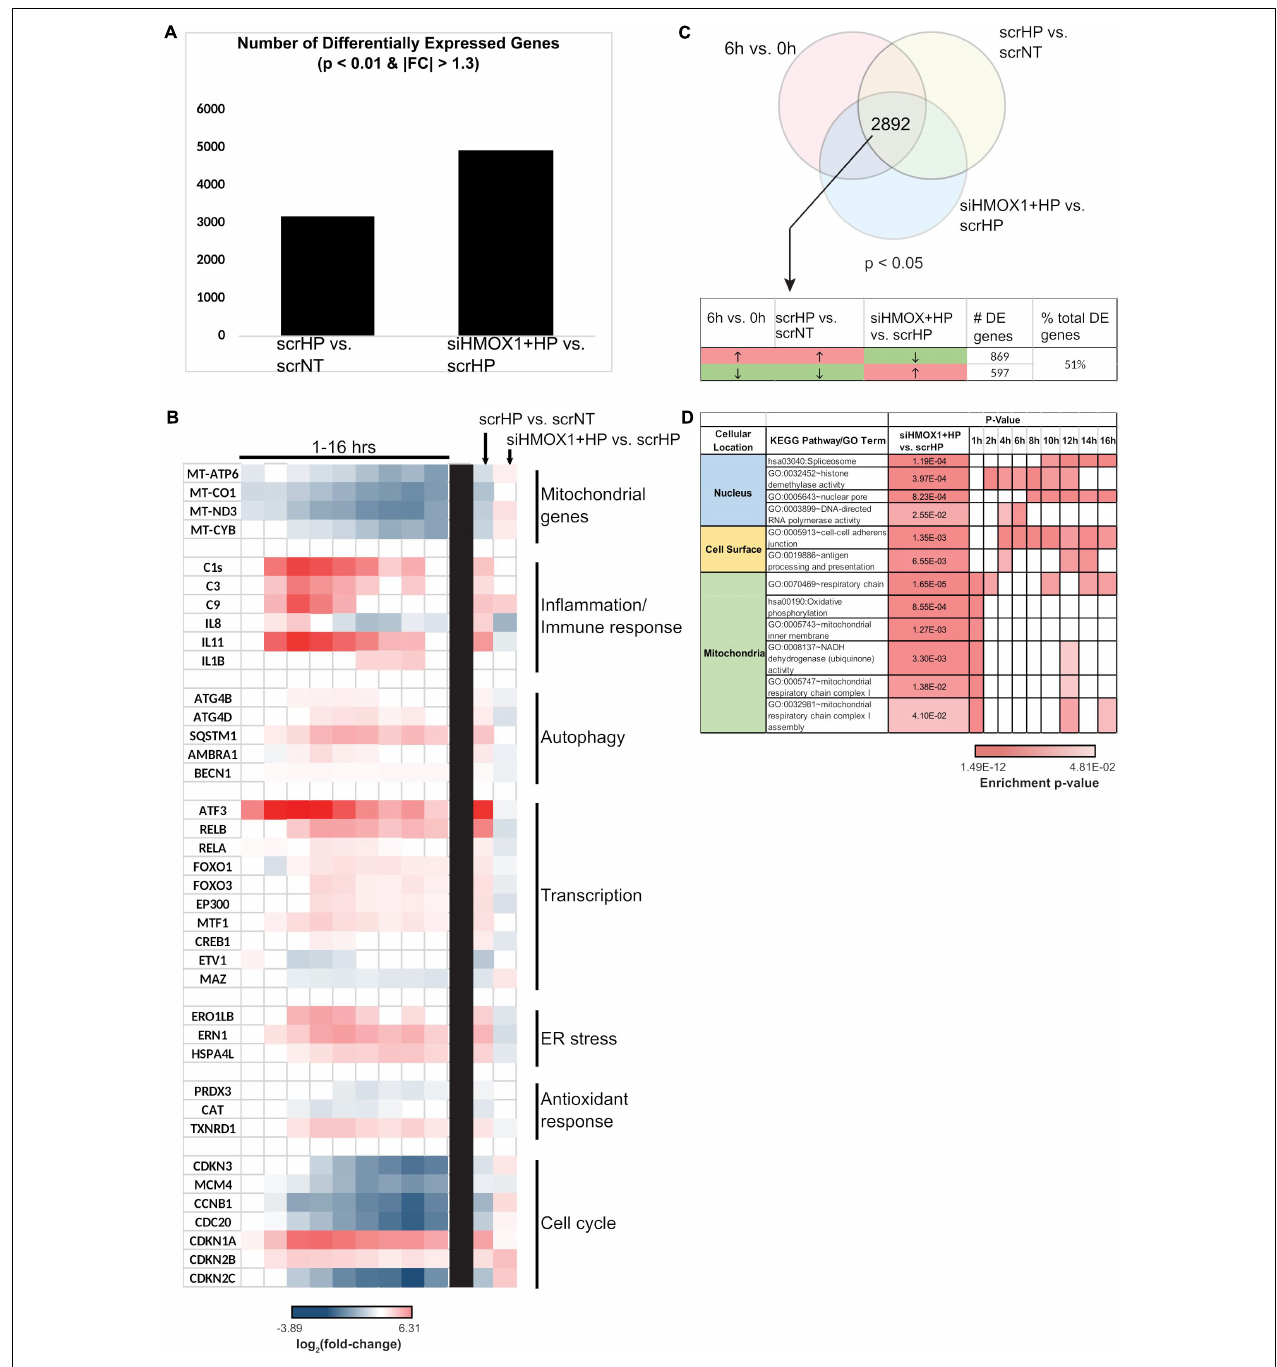
FIGURE 4 | HMOX1 is a global regulator of cell function in HUVECs upon HP treatment. RNA collected from scrNT, scrHP, and siHMOX1+HP samples ( n = 2 per group) was submitted for RNA-seq. (A) The number of differentially expressed genes between scrHP vs. scrNT (i.e., indicating the effect of the HP treatment) and between siHMOX1+HP vs. scrHP (i.e., indicating the effect of the HMOX1 knockdown in response to HP treatment). (B) Log 2 (fold-change) of genes associated with mitochondrial function, inflammatory/immune response, autophagy, transcription, ER stress, anti-oxidant response, and cell cycle in the time-course data (to the left of the black bar) and the knockdown experiment (to the right of the black bar). (C) The Venn diagram indicates the number of overlapping differentially expressed genes between the time-course experiment and the knock-down experiment (i.e., the 6 vs. 0 h time-course data and the treatment groups; p < 0.05). The table indicates the number and percentage of overlapping genes that switch the direction of expression upon HP treatment in HMOX1 deficient HUVECs. (D) KEGG and GO enrichment analysis of the overlapping genes that switch their direction of regulation upon HP treatment in HMOX1 deficient HUVECs. Enrichment of pathways in the time-course data is also shown. The cell’s color indicates the significance of the p -value (the lighter the shade, the less significant, and the darker the shade, the more significant the p -value). The enriched KEGG pathways and GO terms were grouped into three spatial categories, as specified in the table’s first column.